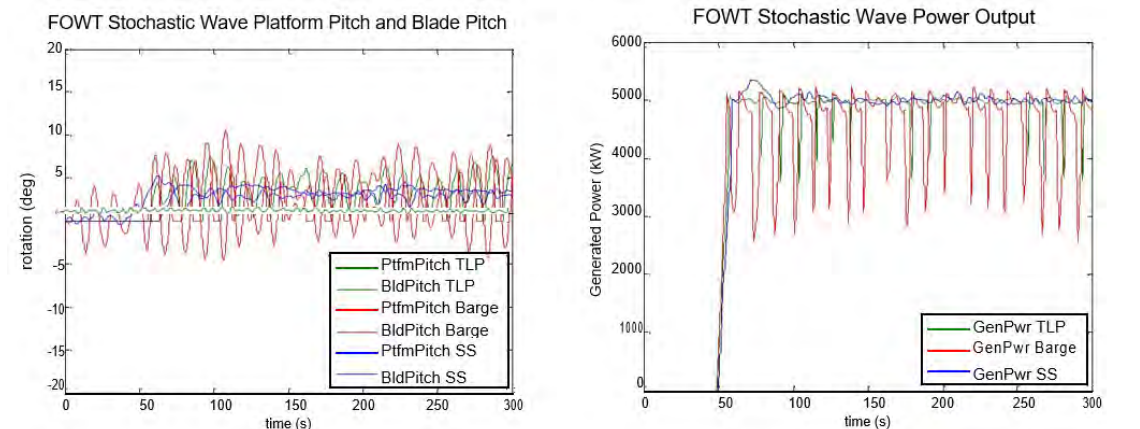
Figure 8. Platform vs Blade PitchResponses (Left) and the Power Output (Right) for Stochastic Wave Case